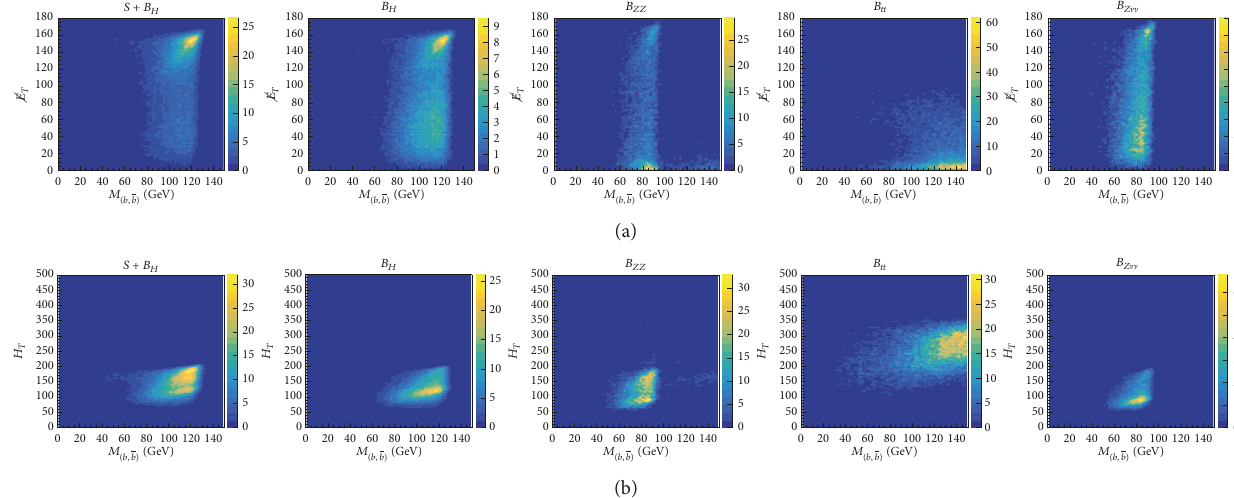
Figure 4: Normalized distributions of missing transverse energy (a) and scalar transverse energy sum (b) for signal versus reconstructed Higgs boson-mass from 𝑏1 and 𝑏2 ( 𝑀 푏,푏 ) with 𝑐 퐻푊 = 0.05 and relevant background